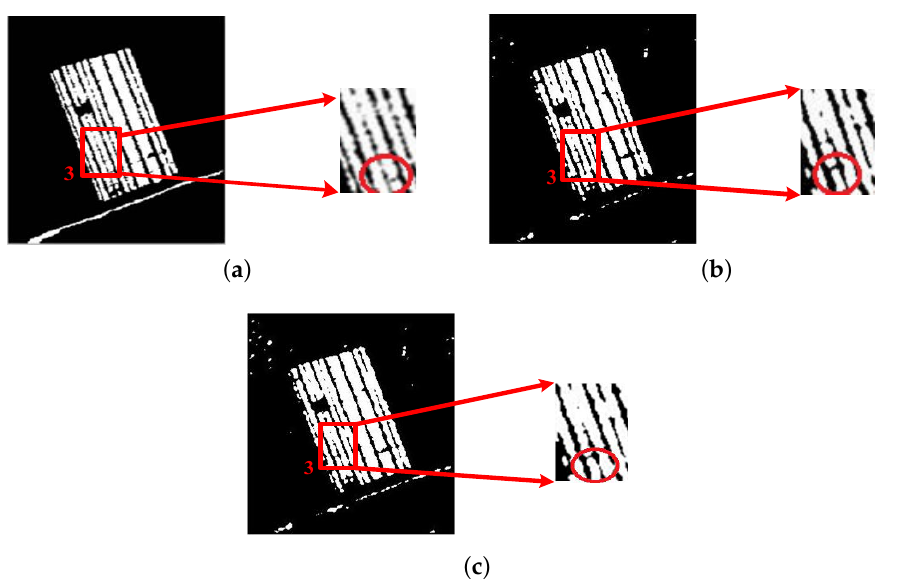
Figure 15. The change detection maps at the three areas on the Farmland D data set: ( a ) Number 1 area in reference. ( b ) Number 1 area with gcForest. ( c ) Number 1 area with the proposed method. ( d ) Number 2 area in reference. ( e ) Number 2 area with gcForest. ( f ) Number 2 area with the proposed method. ( g ) Number 3 area in reference. ( h ) Number 3 area with gcForest. ( i ) Number 3 area with the proposed method.